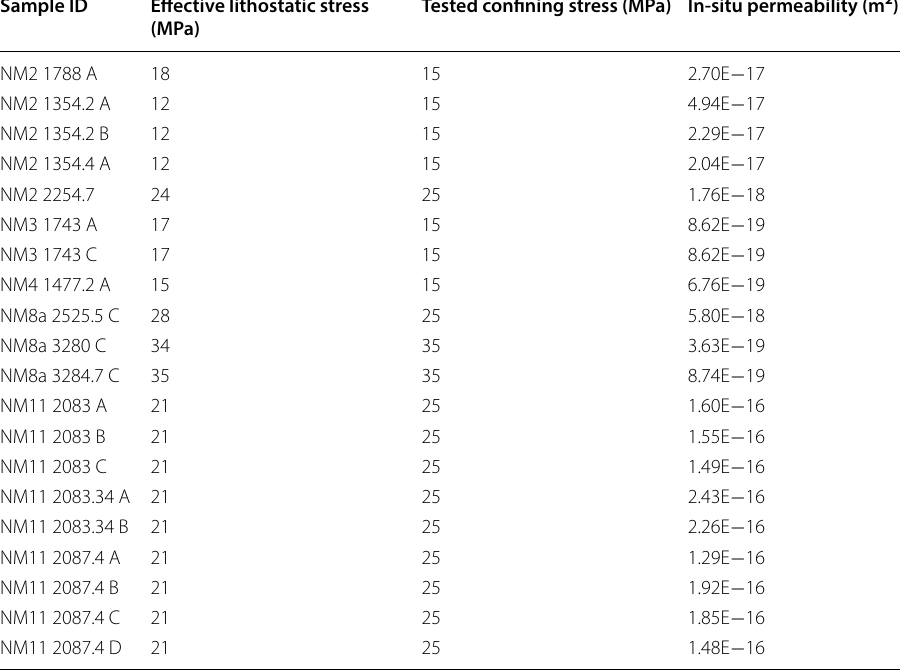
Table 5 Effective lithostatic stress (confining pressure) for each sample with the corre- sponding permeability test pressure used to calculate the in-situ permeability Sample